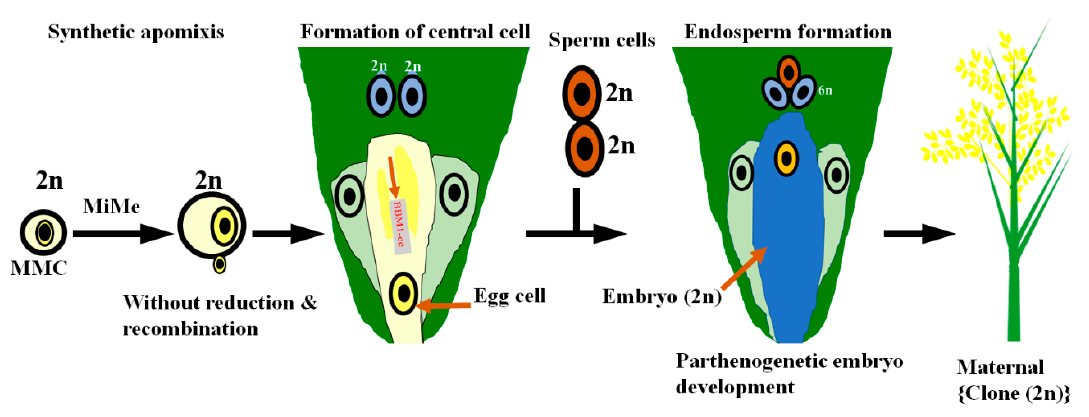
Figure 6. Apomixis technology for single-line HR.